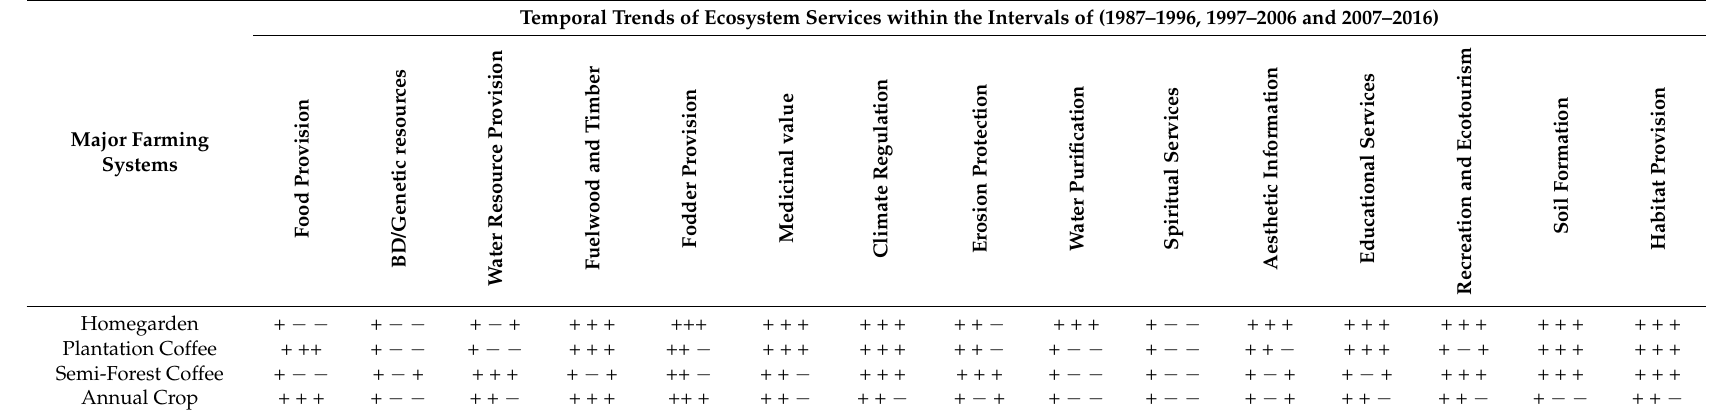
Table 4. Summary of trends and tradeoffs of ecosystem services in the major farming systems in the Yayo